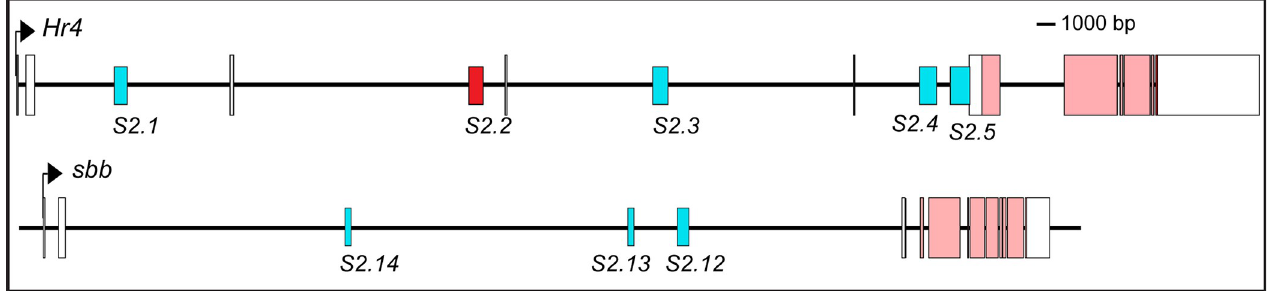
Fig 9. This study identified several trans -regulatory genes that harbor multiple pCREs. Like trx , SCRMshaw identified multiple pCREs within the Hr4 and sbb loci. The short red rectangle indicates a pCRE found to lack noteworthy abdomen epidermis activity, whereas blue short rectangles indicate pCREs with demonstrated abdomen epidermis regulatory